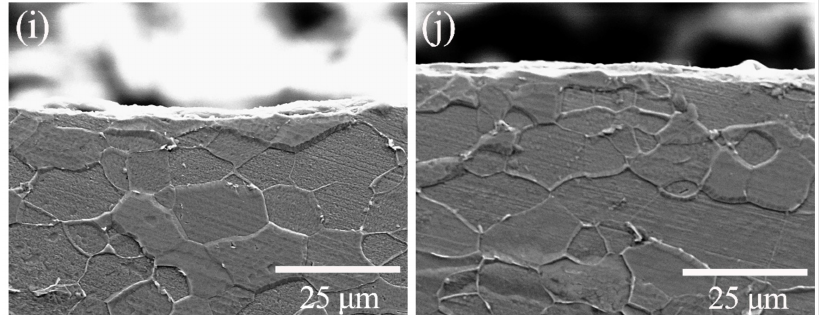
Figure 11. SEM images of laser treated samples: ( a , c ) top-view (ambient air, focused), ( e , e - 1 ) cross-section (ambient air, focused), ( b , d ) top-view (Ar atmosphere, focused), ( f , f - 1 ) cross section (Ar atmosphere, focused), ( g ) top-view (compressed air, defocus distance +4 mm), ( i ) cross-section (compressed air, defocus distance +4 mm), ( h ) top-view (Ar atmosphere, defocus distance +4 mm), ( j ) cross-section (Ar atmosphere, defocus distance +4